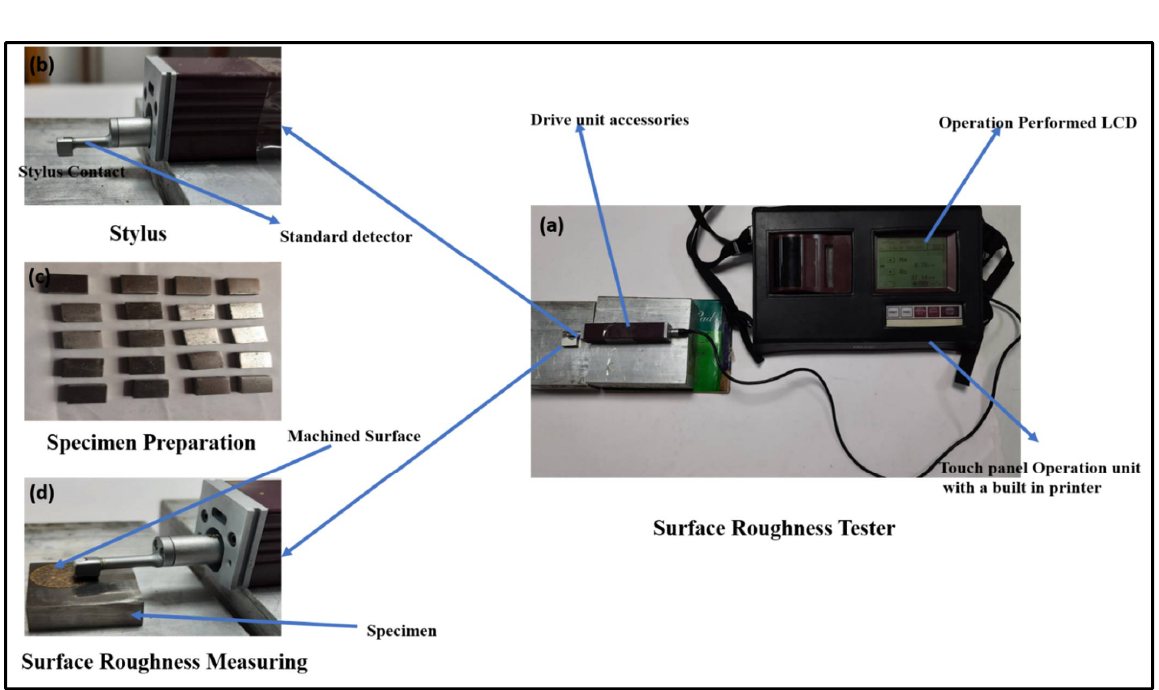
Figure 2. Experimental setup of surface roughness: ( a ) Surface roughness tester. ( b ) Stylus. ( c ) Specimen preparation. ( d ) Surface roughness measuring.